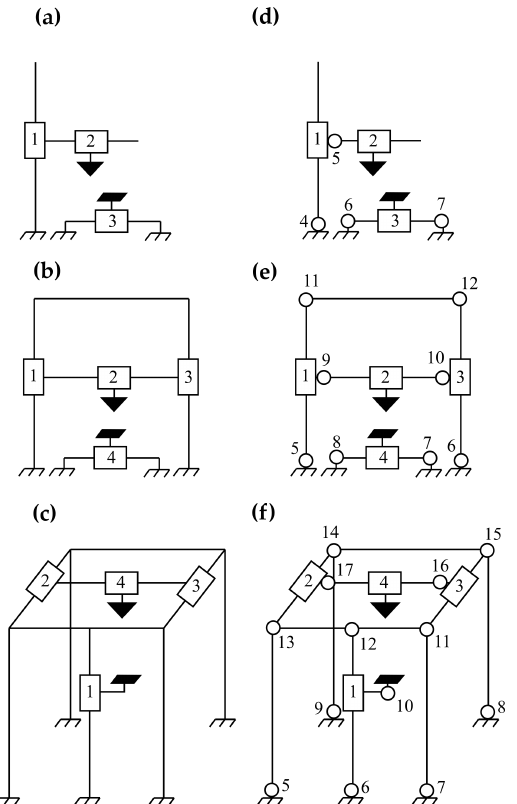
Figure 3. Examples of kinematic schemes for Cartesian 3D printers. Rectangles denote prismatic joints, circles denote spherical joints, a black triangle denotes the printhead, and a black parallelepiped denotes the printbed. Panels ( a – c ) refer to functional kinematic schemes, while the panels ( d – f ) additionally show frame and guide joints that cannot be considered absolutely